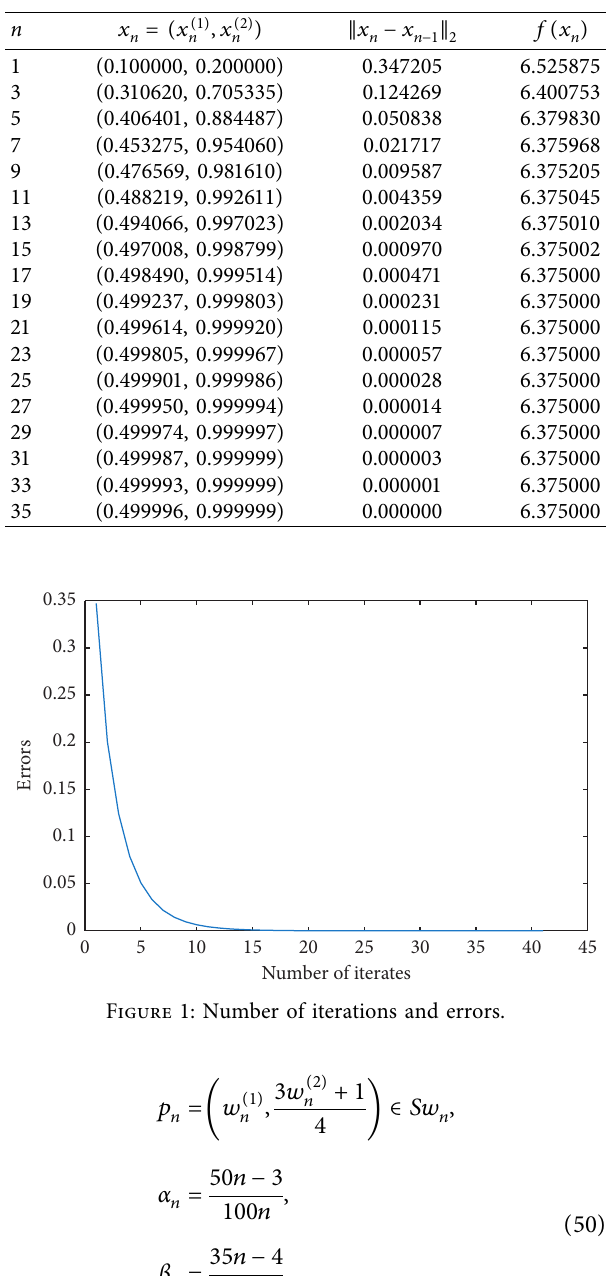
Table 1: Numerical results of Algorithm (49).